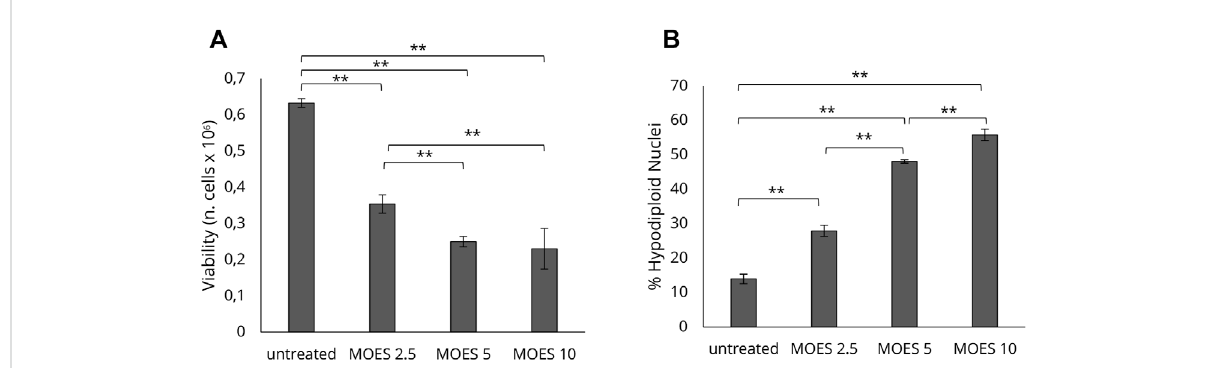
FIGURE 1 Dose-response effect of MOES on the HepG2 cell line. The effect at increasing concentrations (0, 2.5, 5, 10 mg/ml) of MOES on HepG2 cell viability and apoptosis. (A) The number of viable cells analysed by Trypan Blue assay after 72 h of treatment. (B) Percentage of apoptotic cells after 72 h oftreatment,evaluated by propidium iodide staining and fl ow cytometry analysis. All results derived from, at least, three independentbiological experiments (sample size n = 9). Histograms report the mean ± SD (** p < 0.01). Unpaired Student ’ s t-test was used.